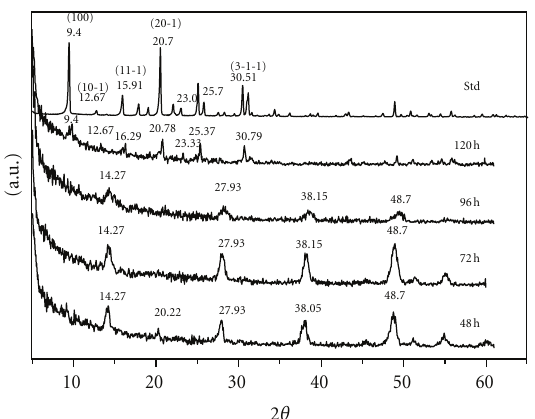
Figure 4: XRD pattern of SAPO 34 crystals synthesized for di ff erent time ranging from 48 h to 120